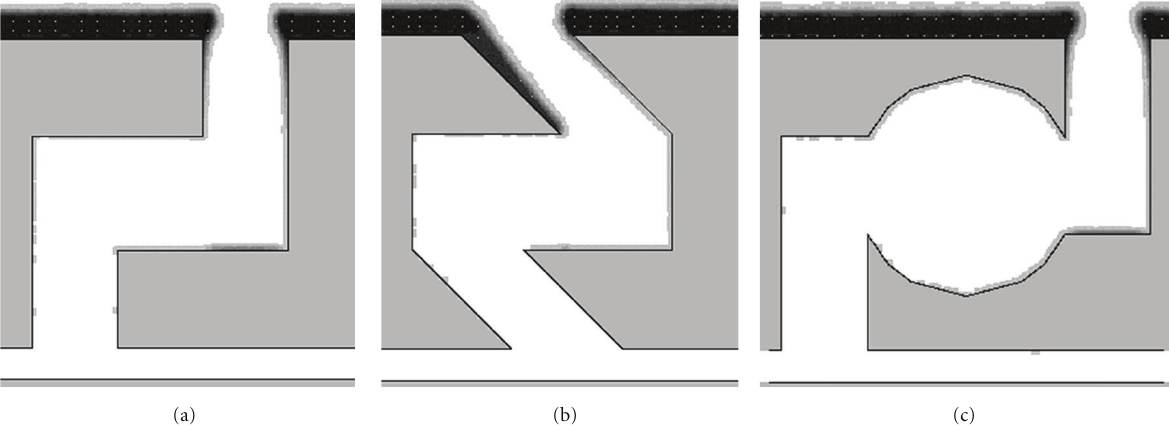
Figure 3: The deposition profile and opacity of the DB with various slots determined by Monte-Carlo simulation: (a) is double-L structure (2L), (b) structure of “ Z -slot”, and (c) double-L structure with cavity (2LC